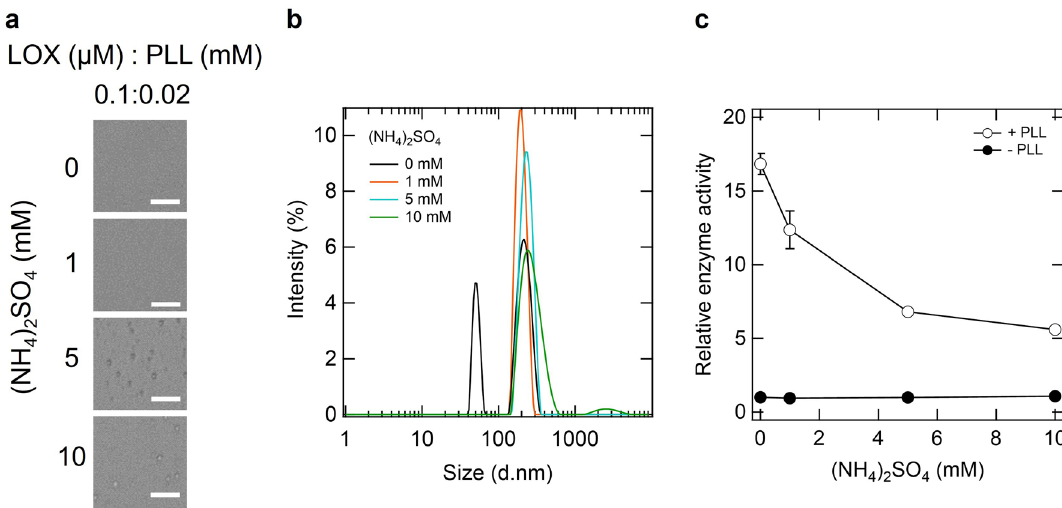
Figure 3. Assembly state and activity of LOX depend on the concentration of ammonium sulfate. ( a ) Bright- field microscopic images of enzyme assemblies. The solution contained 0.1 μM LOX, 0.02 mM PLL, 0–10 mM (NH 4 ) 2 SO 4 , and 20 mM Tris–HCl (pH 8). Scale bar, 20 μm. ( b ) DLS data of sample solution containing 0.1 µM LOX, 0.02 mM PLL, and 20 mM Tris–HCl (pH 8), with 0–10 mM (NH 4 ) 2 SO 4 . ( c ) Enzymatic activity of LOX in the presence of PLL and ammonium sulfate. Relative enzyme activity was defined as the initial reaction velocity in each condition divided by that in the absence of PLL and (NH 4 ) 2 SO 4 .